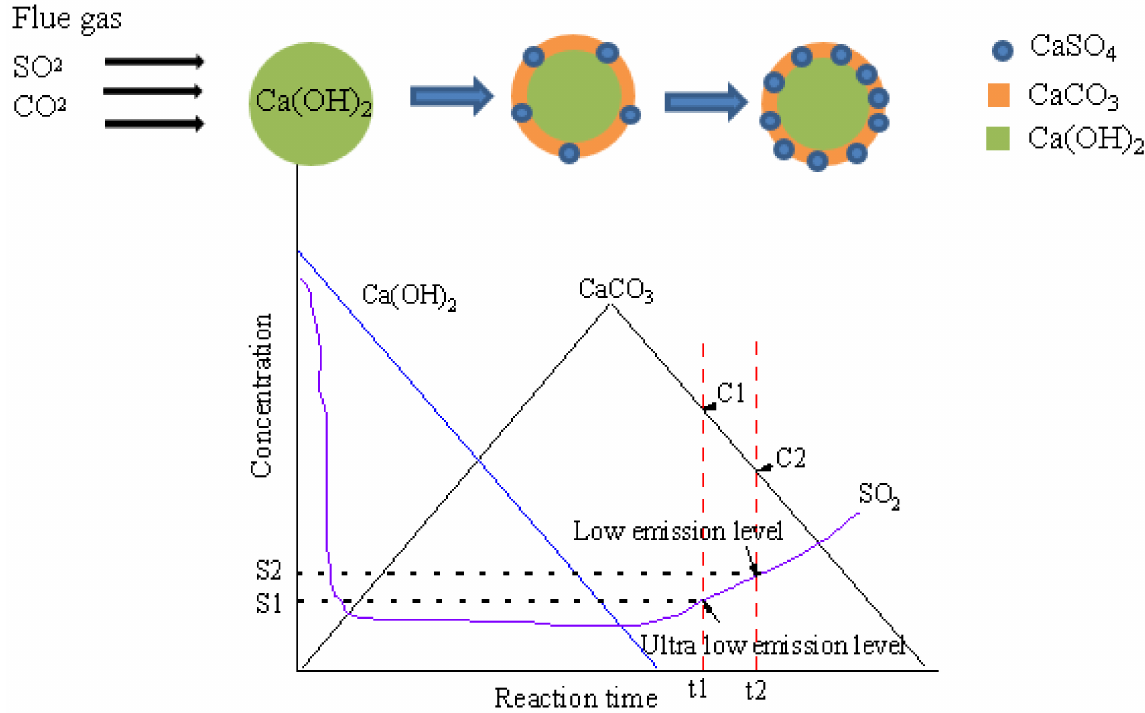
Figure 13. Schematic diagram of desulfurization process of sintering flue